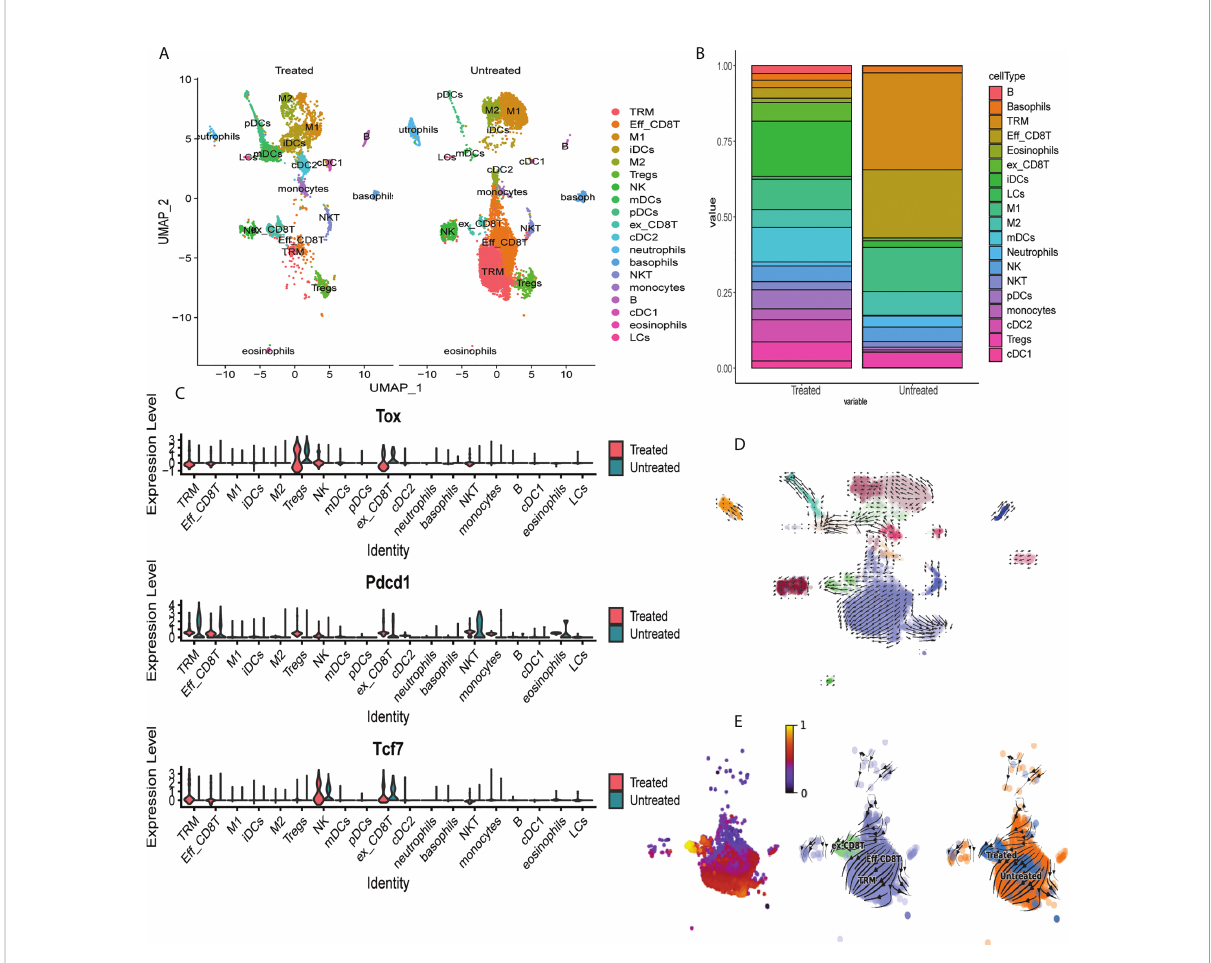
FIGURE 6 Single cell RNAseq identi fi es expansion of exhausted CD8 T cells in skin of mice treated with tofacitinib. (A) UMAP plots of immune cell clusters identi fi ed in the skin of Tofa-treated (Treated) and control mice (Untreated). Note the marked decrease in the proportion of the effector CD8+T cells (Eff_CD8T) and TRM cells, and the expansion of exhausted CD8+ T cells (ex_CD8T) in the skin of Tofa-treated mice. (B) Stacked bar plot showing distribution of each cluster relative to the total number of cells per condition. (C) Violin plots showing mRNA transcript expression levels of canonical exhaustion markers including Tox , Pdcd1 , and Tcf7 encoding for TOX, PD1, and TCF1, respectively, across different clusters in Tofa-treated and control mice. RNA velocity analysis reveals that effector CD8+ T cells give rise to TRM and ex_CD8 T cells in AA-affected skin in C3H/HeJ mice. (D) RNA velocity plots of immune cell clusters identi fi ed in the skin of Tofa-treated (Treated) and control mice (Untreated). (E) RNA velocity plots and pseudotime analysis of CD8 T cell clusters identi fi ed in the skin of Tofa-treated and control